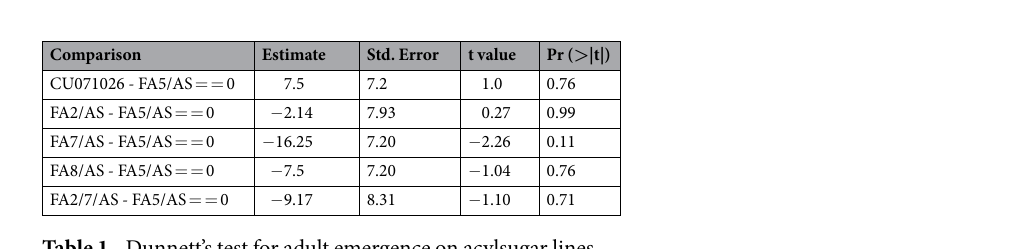
Table 1. Dunnett’s test for adult emergence on acylsugar